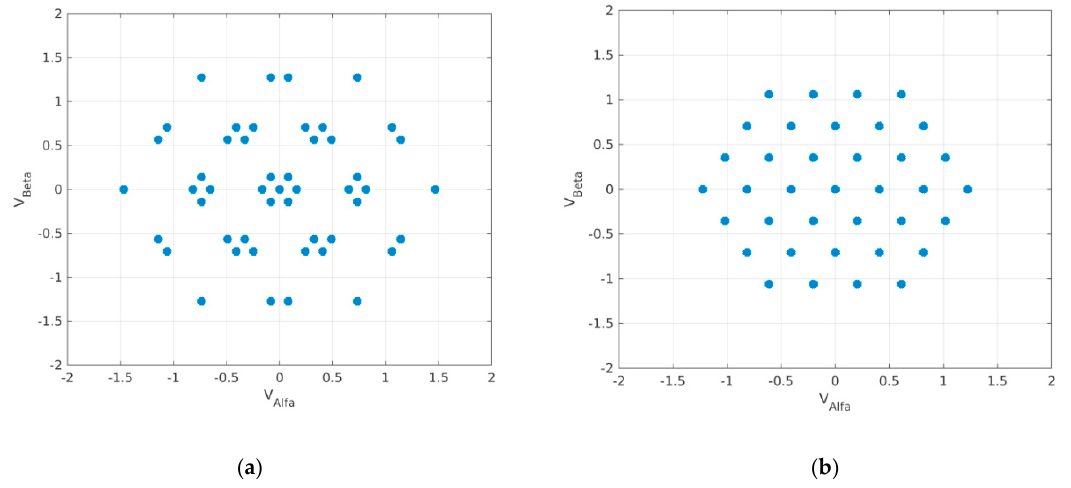
Figure 4. Vectors considering: ( a ) V DC 1 reduces to 80% of their nominal value; ( b ) V DC 1 reduces to 50% of their nominal value, in pu.